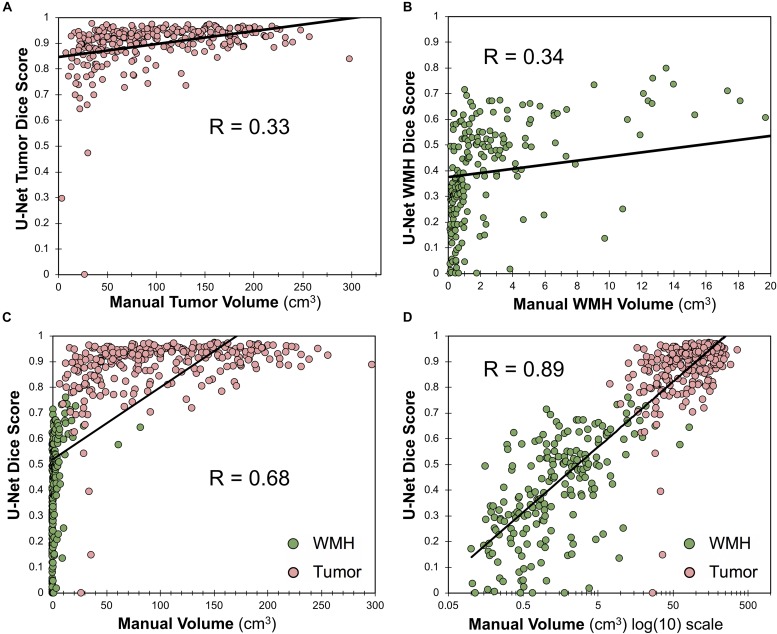
Relationship between Dice score and lesion volume. (A) Scatter plot and Pearson correlation between WT volume and WT Dice score. (B) Scatter plot and Pearson correlation between WMH volumes and WMH Dice scores. (C) Scatter plot and Pearson correlation between volumes and Dice scores for both WMH and WT. (D) Scatter plot and Pearson correlation between log(10) transformed volumes and Dice scores for both WMH and WT.